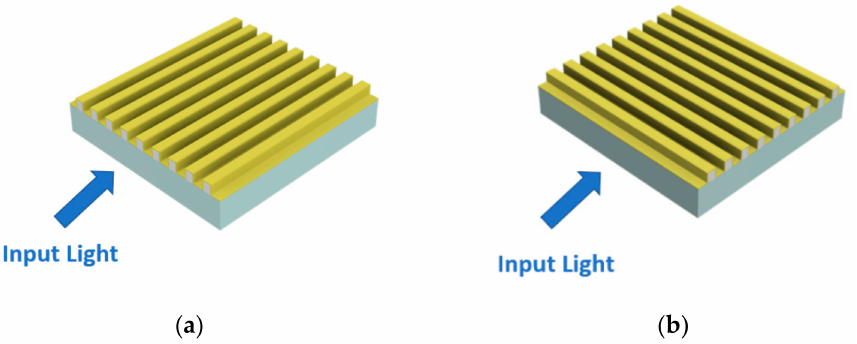
Figure 4. ( a ) “GNG-based longitudinal” configuration. ( b ) “GNG-based orthogonal”